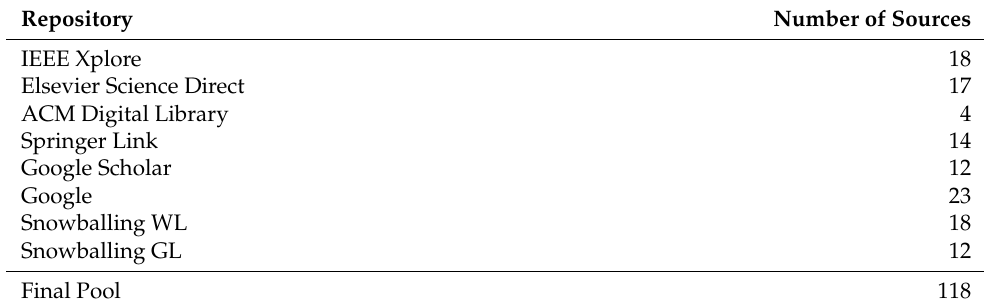
Table 4. Number of papers after quality assessment of sources defining the final pool.